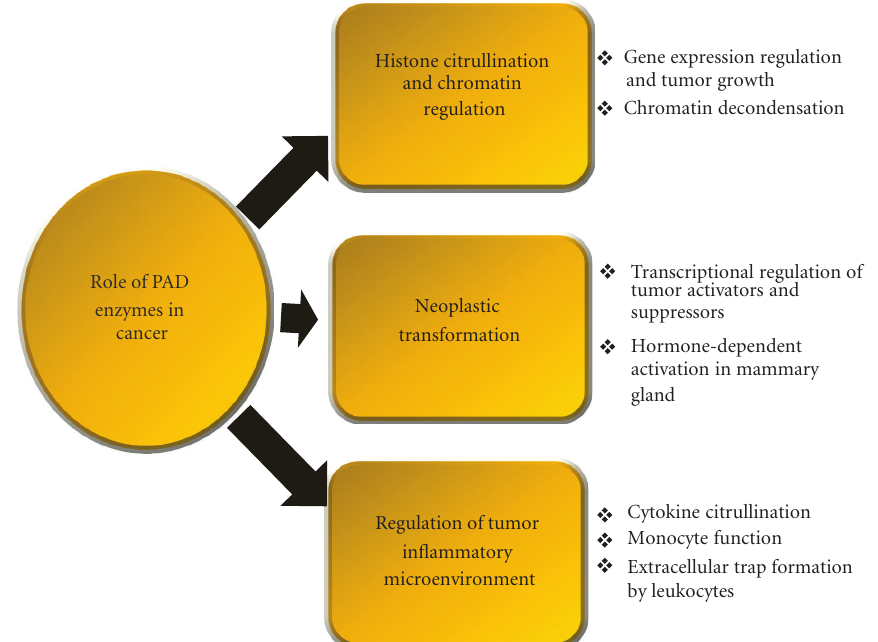
Figure 7: Potential role of PAD enzymes in cancer